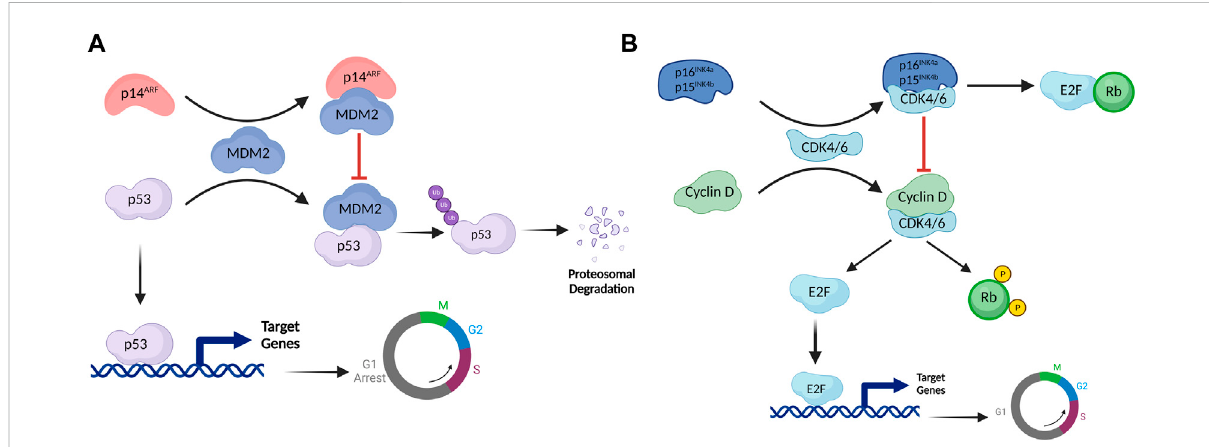
FIGURE 2 TheINK4/ARFcellcycleregulatorynetwork. (A) Thep53-MDM2pathwayiscontrolledbytheupstreameffectorproteinp14 ARF .Byestablishinga complex with MDM2, p14 ARF permits p53 to activate its transcriptional targets. MDM2 ubiquitinates p53, which mediates proteasomal degradation in normal conditions. However, when MDM2 interacts with p14 ARF , NoLS of MDM2 is exposed, resulting in MDM2 sequestration in the nucleolus. MDM2 sequestration prevents degradation of p53, allowing it to activate its transcriptional targets and arrest the cell cycle in the G1 phase. (B) Theretinoblastomapathwayisregulatedbyp16 INK4a andp15 INK4b .E2FisatranscriptionfactorthatactivatesgenesinvolvedinthetransitionfromG1to M phase. Rb inhibits this function of E2F by establishing a complex with it. Under normal conditions, the cyclin D-CDK4/6 complex phosphorylates Rb. Phosphorylated Rb doesn ’ t engage with E2F, as a result, E2F binds to target genes to activate them. Once expressed, p16 INK4a /p15 INK4b inhibits cyclin D-CDK4/6 complex formation, keeping Rb hypophosphorylated. Hypophosphorylated Rb forms a complex with E2F, inhibiting its transcriptional